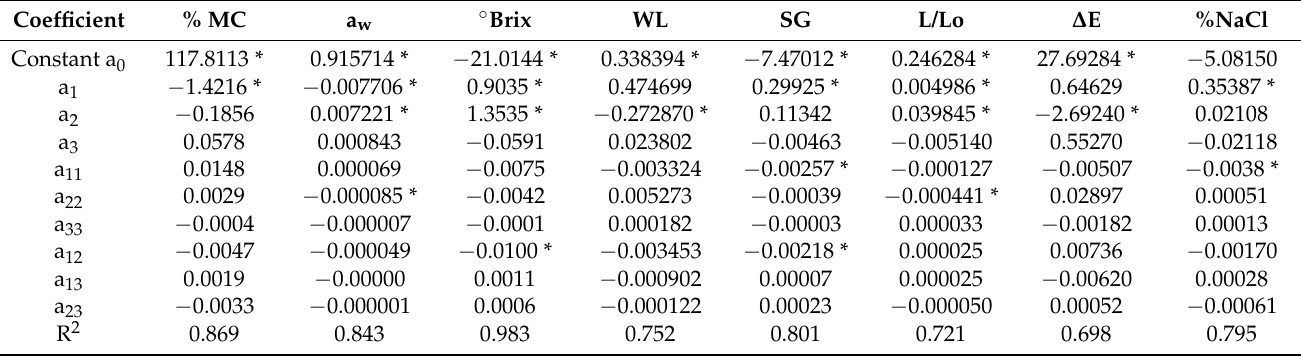
Table 2. Statistical analysis of the factors of polynomial equations (RSM) with variance analysis (ANOVA).